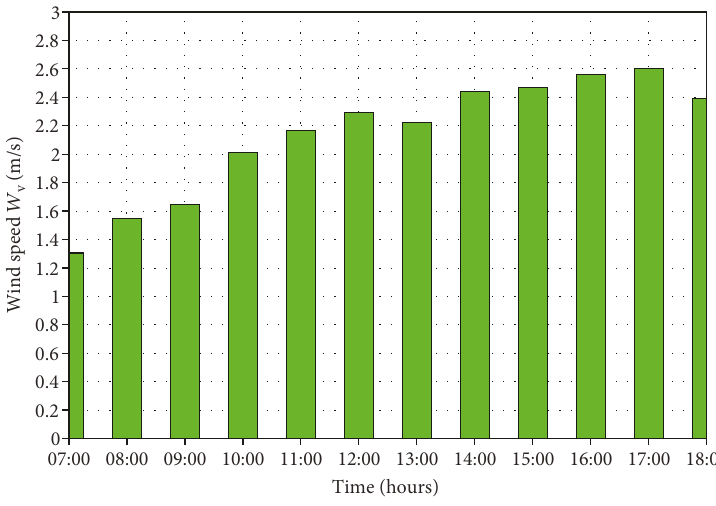
Figure 6: Yearly hourly average values of wind